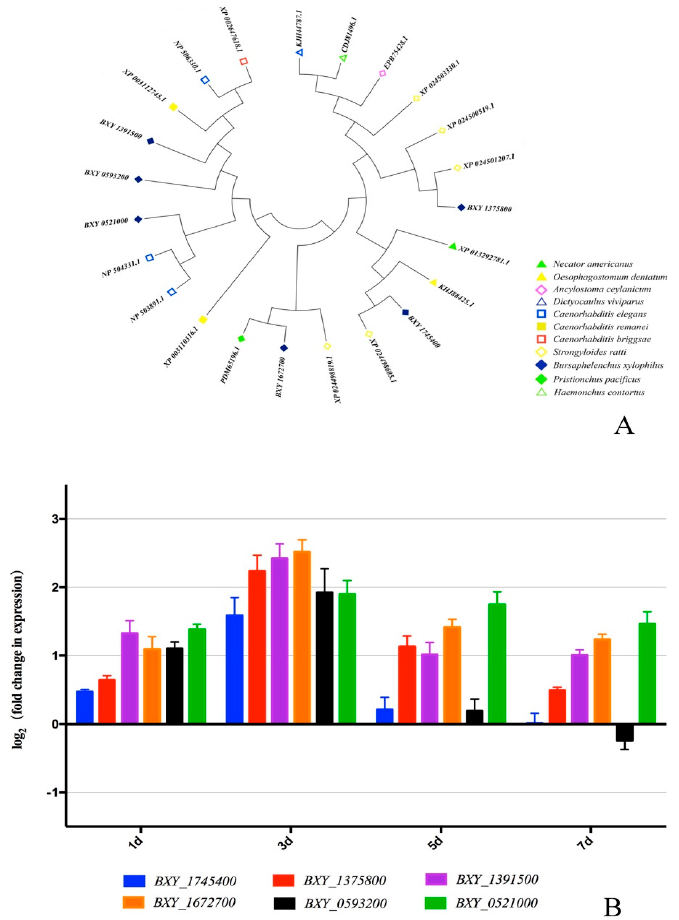
Figure 4. Identification and transcript pattern analysis of six low-temperature-related BxGPCRs. ( A ). Analysis on phylogenetic trees of six deduced protein sequences with other organisms. Labels at the end of each branch are gene id/NCBI accessions of each gene. Different shapes stand for the Latin name of each organism. ( B ). Transcript abundance analysis of six BxGPCRs under low temperature.